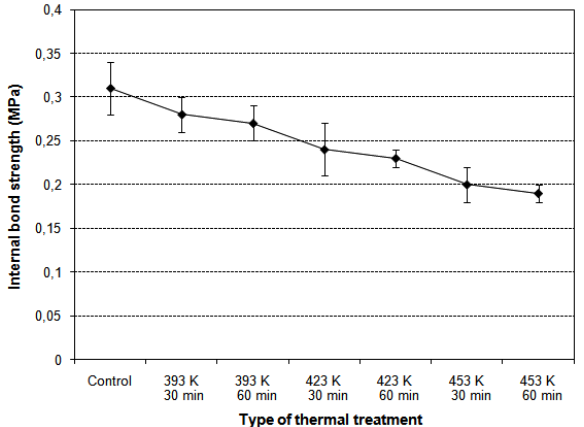
Figure 4. Effect of the thermal treatment of the wood fibers of E. camaldulensis on the internal bond strength of the light MDF panels. The vertical lines through the bars rep- resent the standard deviation from the average value of twenty-one